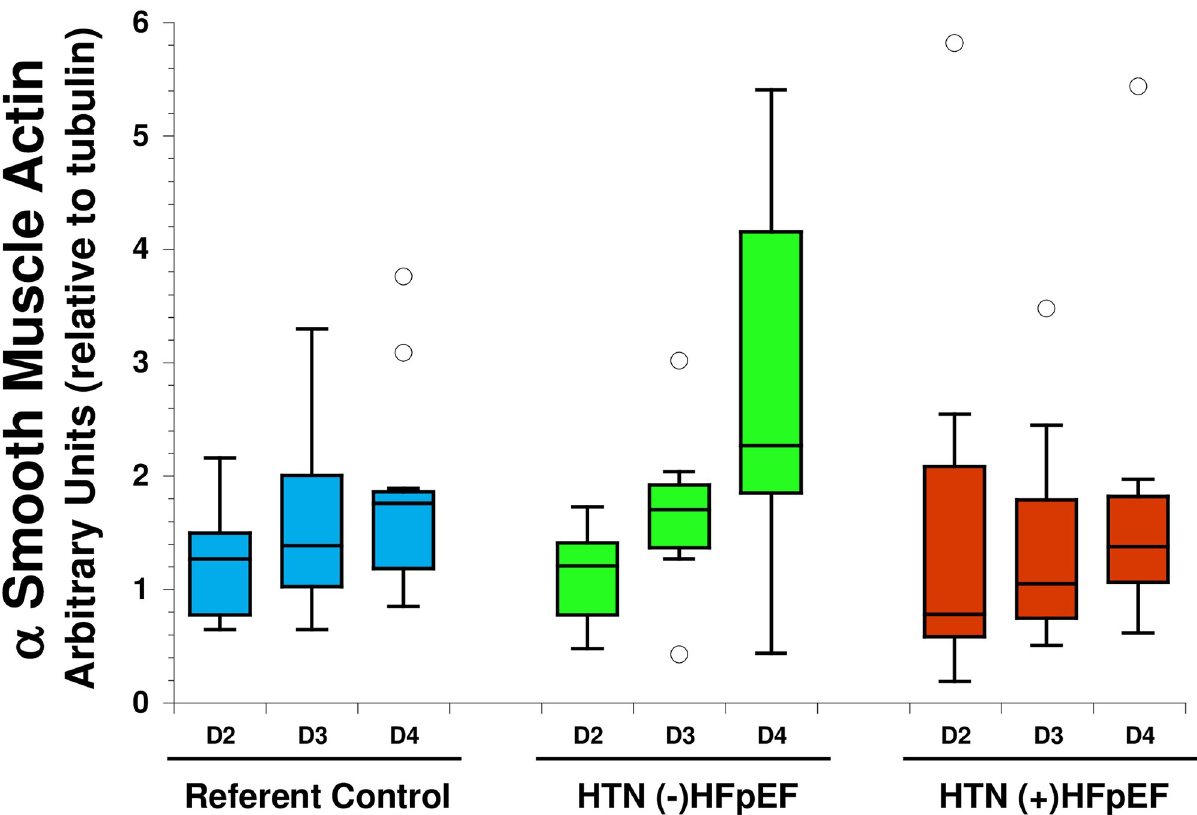
Fig 6. α SMA production by primary fibroblasts was quantified by immunoblot analysis and determined relative to expression of tubulin at day 2, day 3, and day 4. Protein production was evaluated in cells from P2 or P3. Blue: Referent control (n = 10), Green: HTN (-) HFpEF (n = 7), Red: HTN (+) HFpEF (n = 10). � p < 0.05, open circles represent outlier